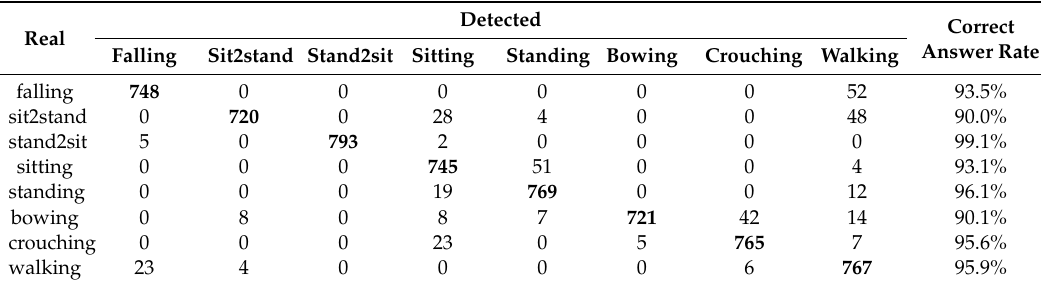
Table 4. Result of motion detection with the 3D CNN.